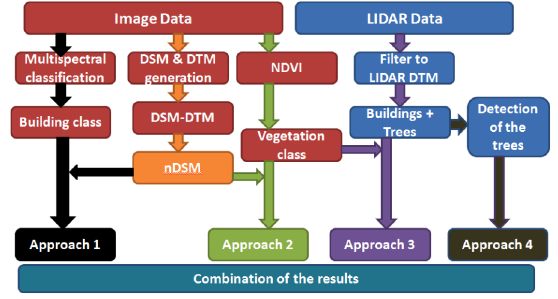
Fig. 1. Workflow of the building